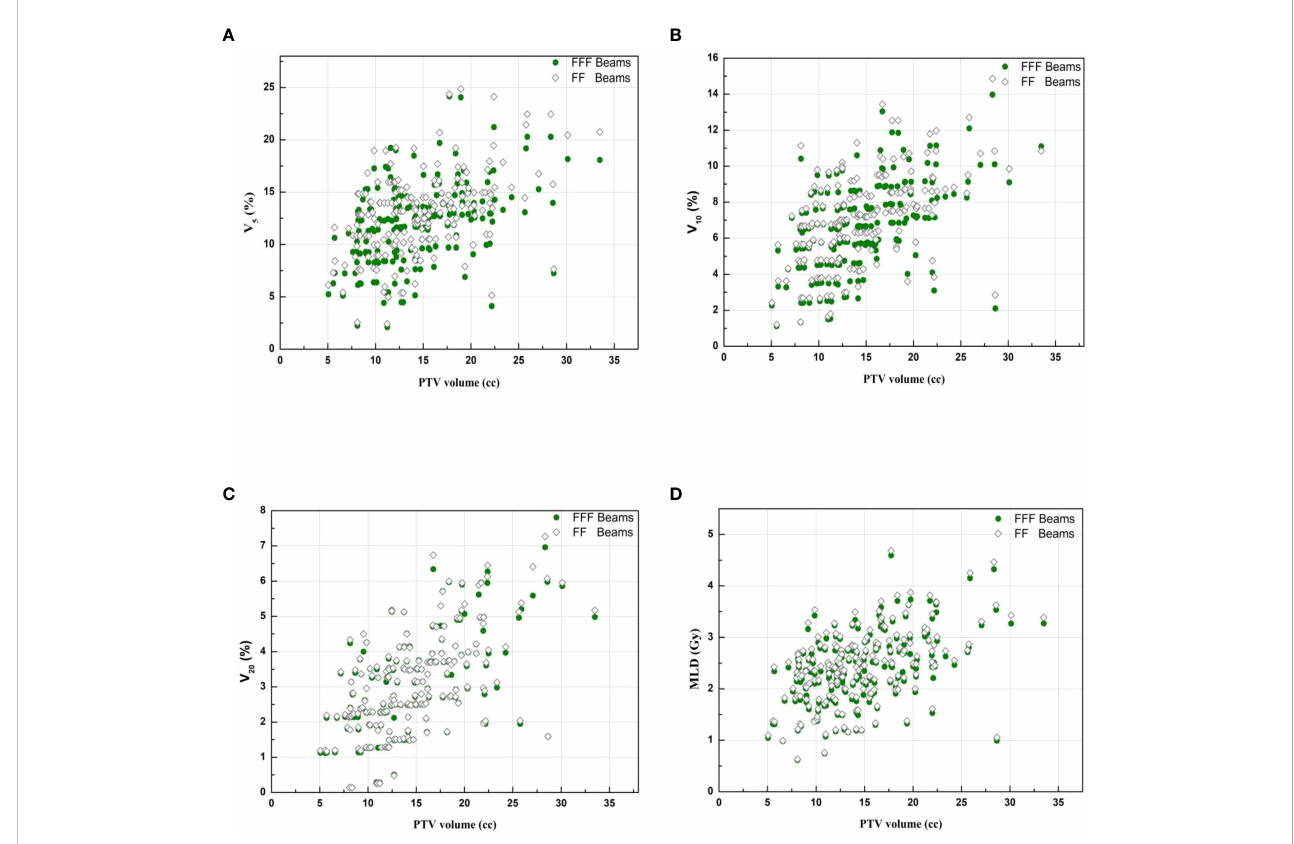
FIGURE 2 Lung representative dosimetric parameters for FFF beams and FF beams. (A) V 5 of lung. (B) V 10 of lung. (C) V 20 of lung. (D) MLD of